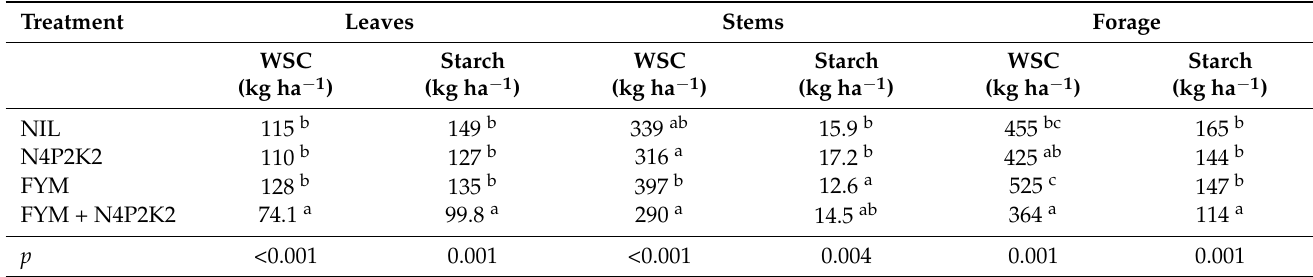
Table 4. Effect of fertilization treatments on water-soluble carbohydrates (WSC) and starch hectare production in lucerne leaves, stems and whole forage in the first cut 2014.